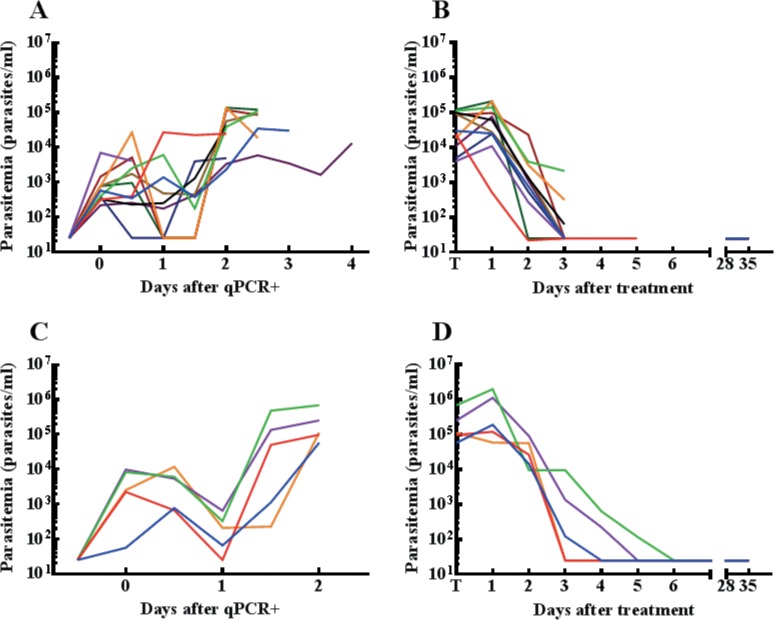
Parasitemia before and after treatment.Parasitemia measured by qPCR up until initiation of treatment (A and C) and from treatment onwards (B and D) in previously NF54 protected volunteers (A and B) and controls (C and D). Each line represents an individual subject with the same colour before and after treatment. Values shown as 25 Pf/ml were negative (i.e. half the detection limit of the qPCR: 50 parasites/ml).